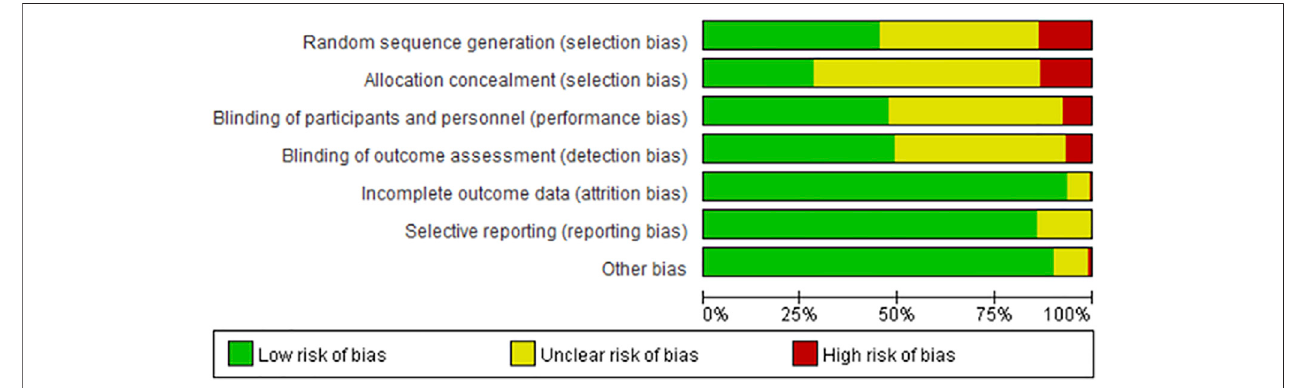
FIGURE 2 | Percentage of risk of bias for all quali fi ed